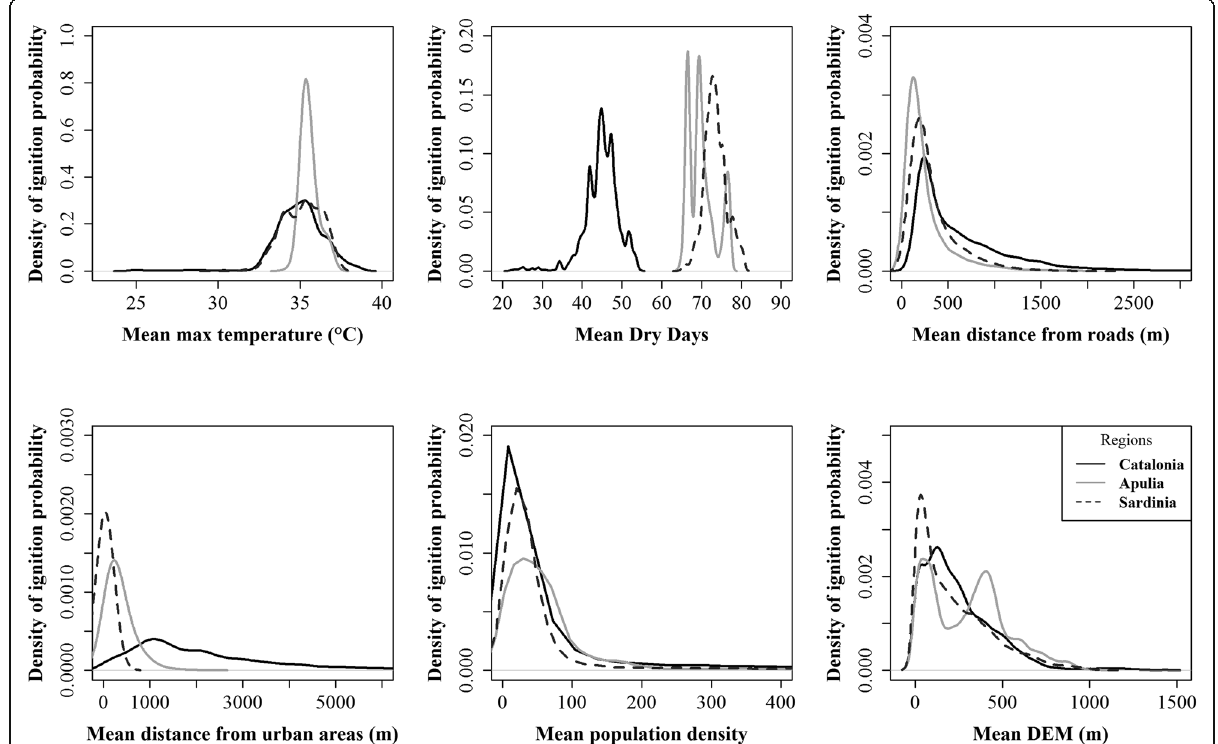
Fig. 4 The probability density function of fire ignition occurrence for mean max. temperature ( a ), mean dry days ( b ), mean distance from roads ( c ) and urban areas ( d ), mean population density ( e ), and mean elevation (DEM, f